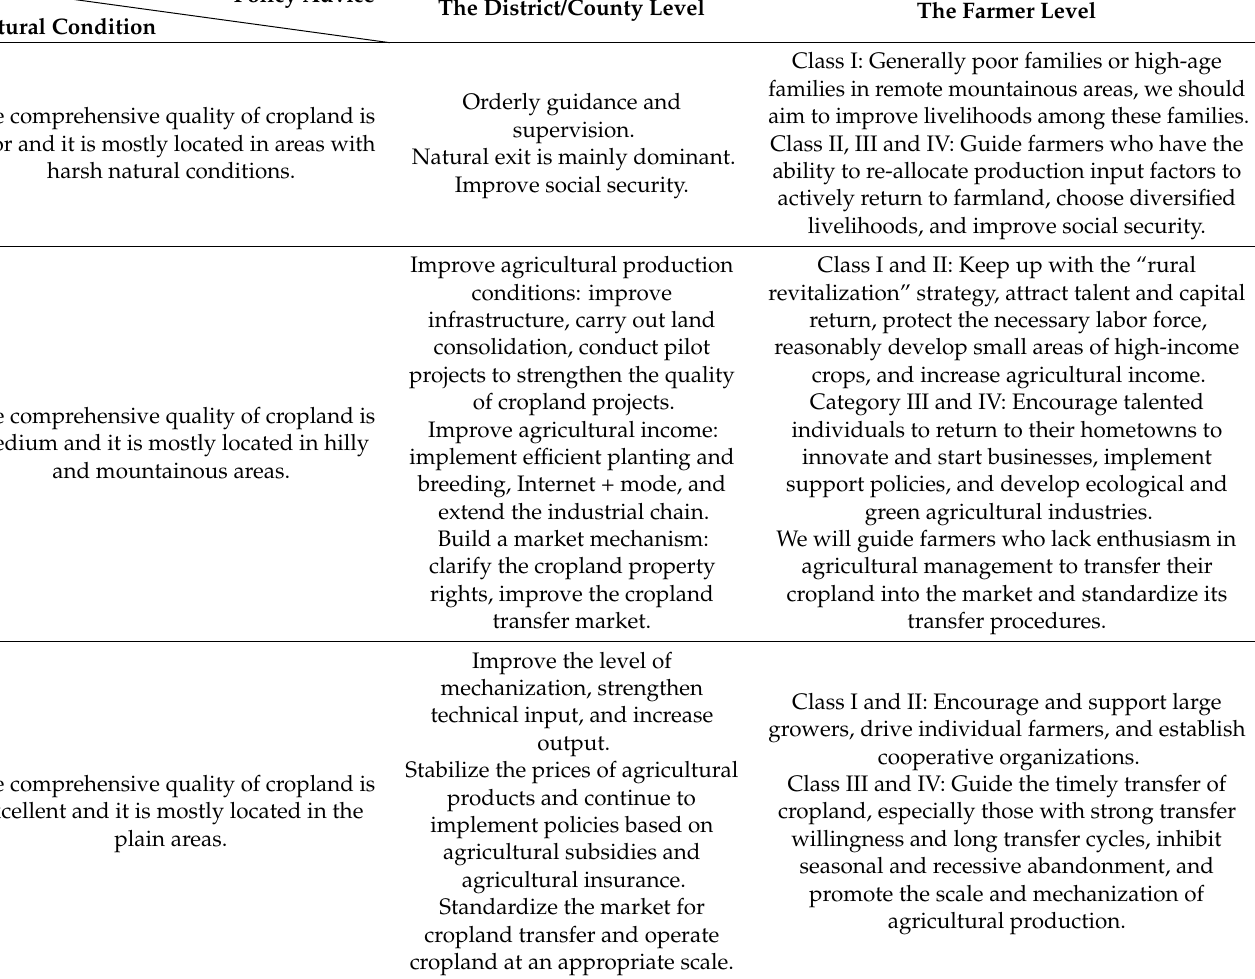
Table 4. Policy suggestions on alleviating abandoned cropland by